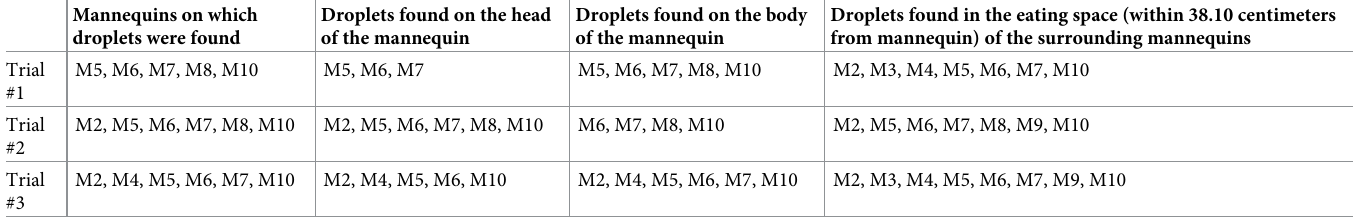
Table 3. (Experiment 3): Droplet spread in normal cafeteria seating positions. Mannequins on which droplets were